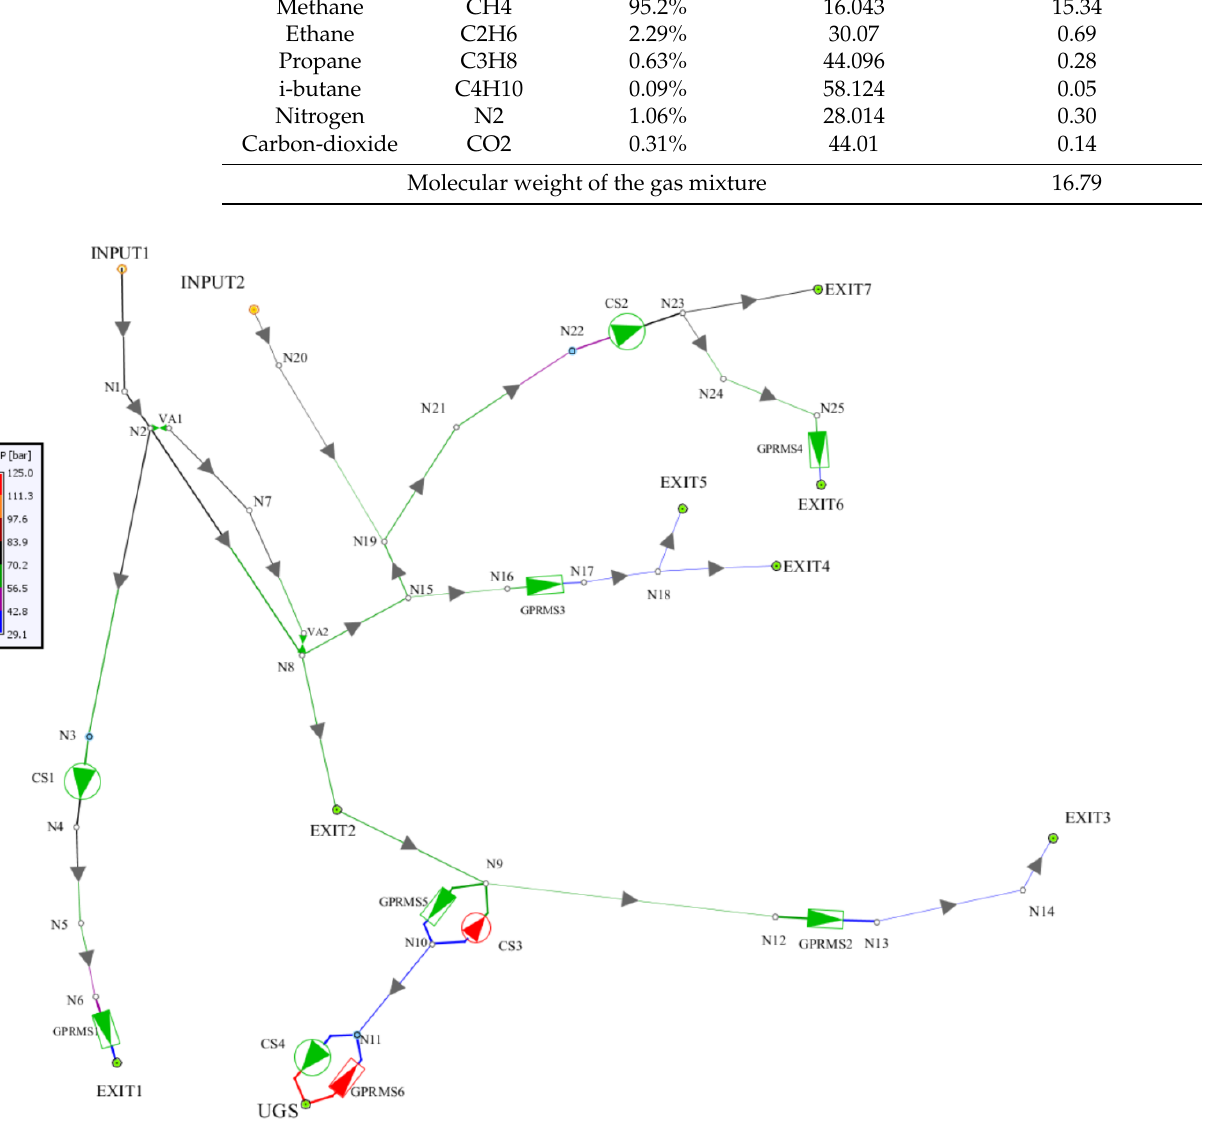
Figure 2. Gas network model constructed in SIMONE. Within case study one, six simulations were performed, as indicated in Table 2. The same gas pipeline parameters, presented in Table 3, were used in all defined scenarios. The pipeline efficiency was taken as 1, and the total length of the gas network was 681.5